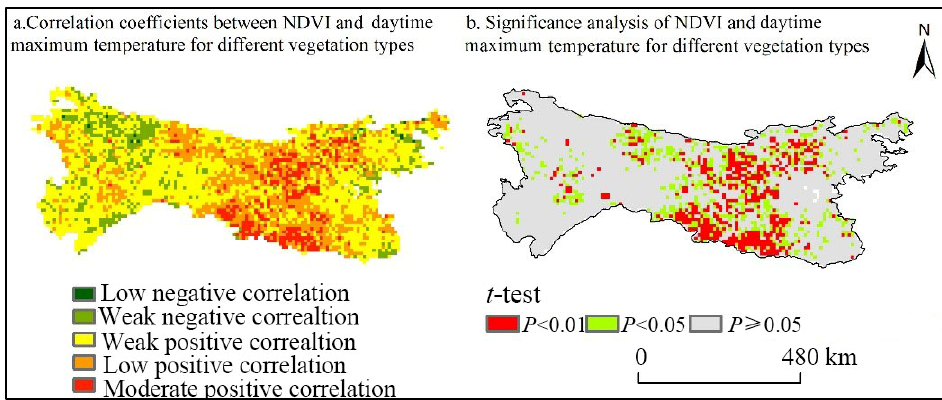
Figure 6. Correlation coefficient ( a ) and t -test analysis ( b ) between NDVI and daytime maximum temperature (T max ) of different vegetation types from 1982 to 2015.